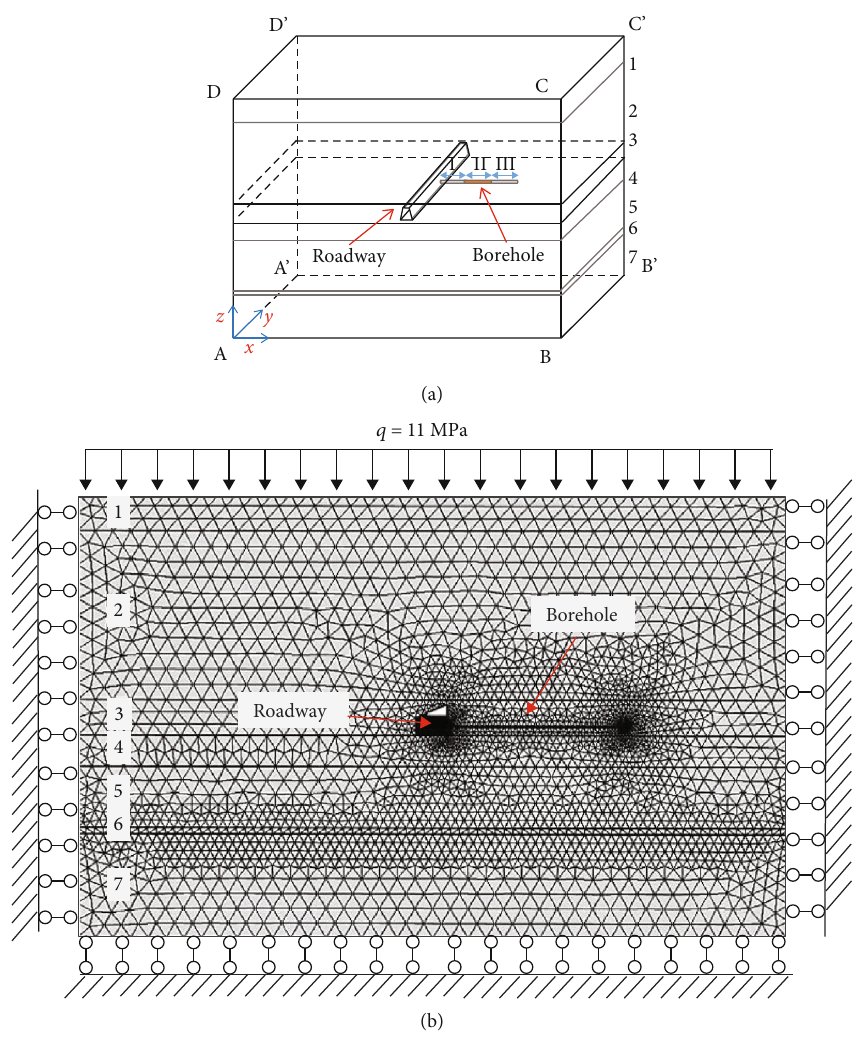
Figure 8: Numerical calculation model: (a) spatial schematic map; (b) grid